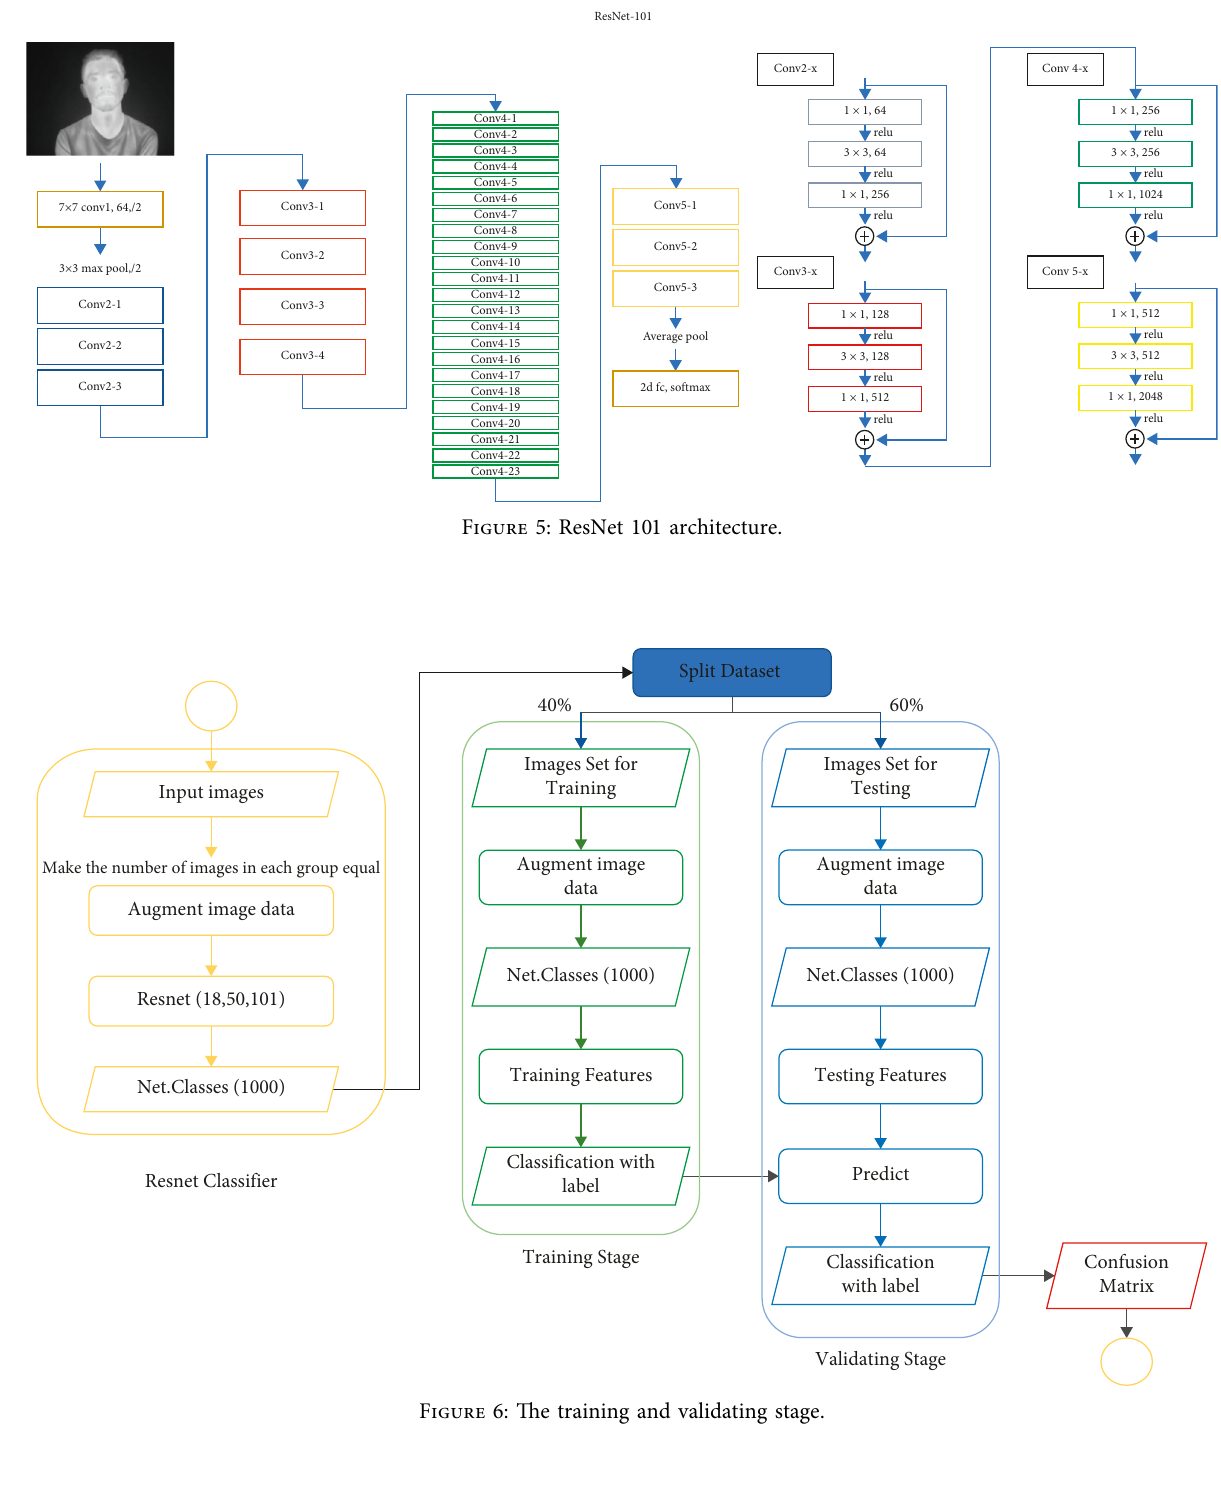
Figure 6: The training and validating stage.